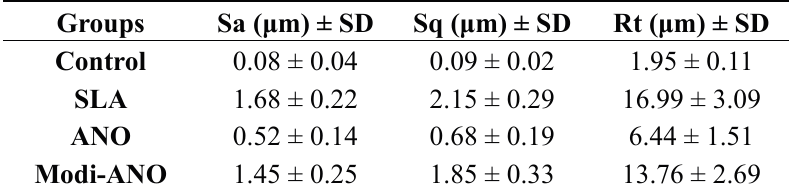
Figure 1. Scanning electron microscopy (SEM) images of surface-modified titanium substrates. SLA: sandblasted and acid etched Ti, ANO: anodized Ti, Modi-ANO: sandblasted/acid etched and anodized Ti. Table 1. Surface roughnesses of the titanium substrates as determined by stereo scanning electron